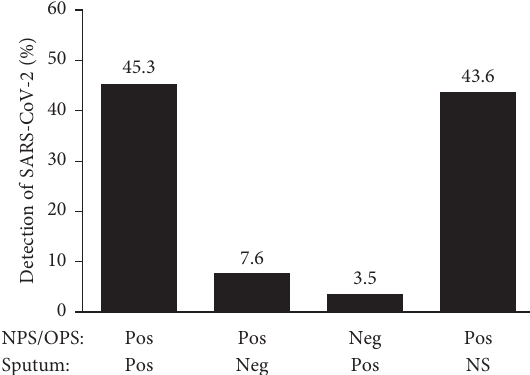
Figure 1: Classification of the study subjects by different types of respiratory specimens. Upper (NPS/OPS) and lower (sputum) respiratory specimens of the study subjects were retested for severe acute respiratory syndrome coronavirus 2 (SARS-CoV-2) using the Allplex 2019-nCoV assay. The study subjects ( N � 342) were confirmed as positive for SARS-CoV-2 in both NPS/OPS and sputum at a rate of 45.3% ( N � 155), SARS-CoV-2 positive in their NPS/OPS specimens but negative in their sputum at a 7.6% ( N � 26) rate, and SARS-CoV-2 negative in their NPS/OPS specimens but positive in their sputum at a 3.5% ( N � 12) rate. Some (43.6%, N � 149) were positive in NPS/OPS when sputum samples were not submitted. NPS: nasopharyngeal swab; OPS: oropharyngeal swab; NS: specimens were not submitted for COVID-19 (coronavirus disease 2019) testing; Pos: positive; Neg: